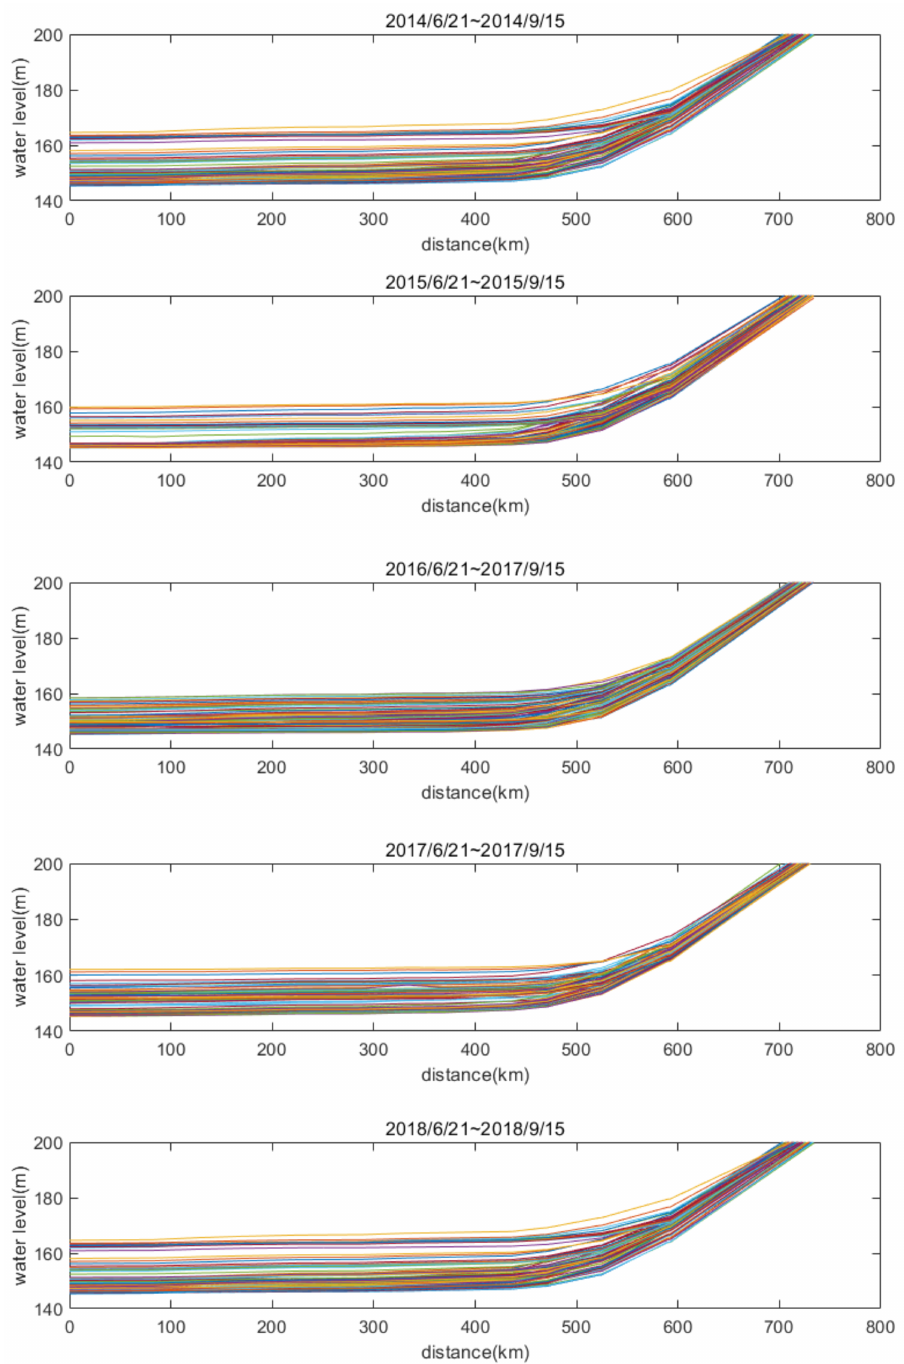
Figure 9. Water surface line during the main flood season from 2014 to